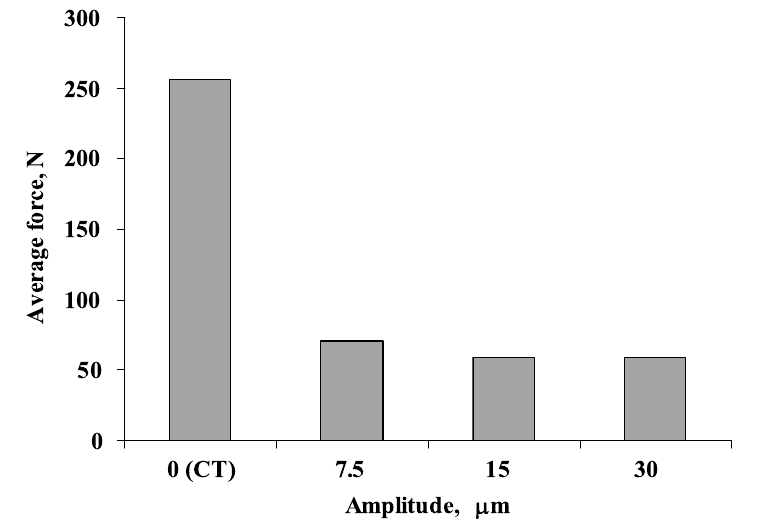
Fig. 2. Effect of frequency on cutting force in dry turning of Inconel 718 (cutting speed 335.24 mm/s; feed rate 0.2